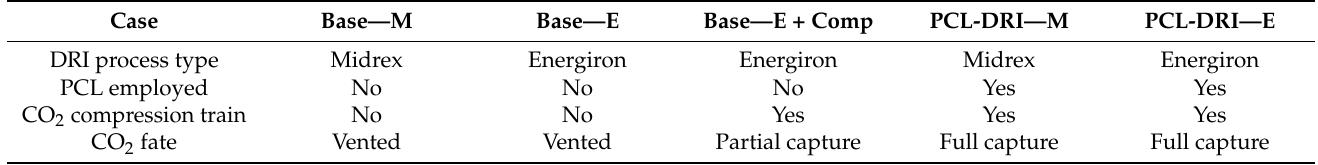
Table 1. Summary of cases simulated in